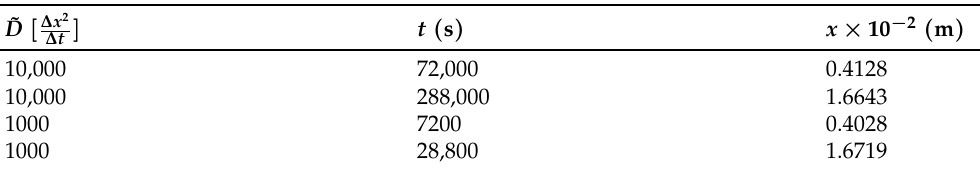
Table 1. The positions in the domain where the diffusion velocity u d = − D ∇ c sound C s 0.577 ∆ x ∆ t ≈